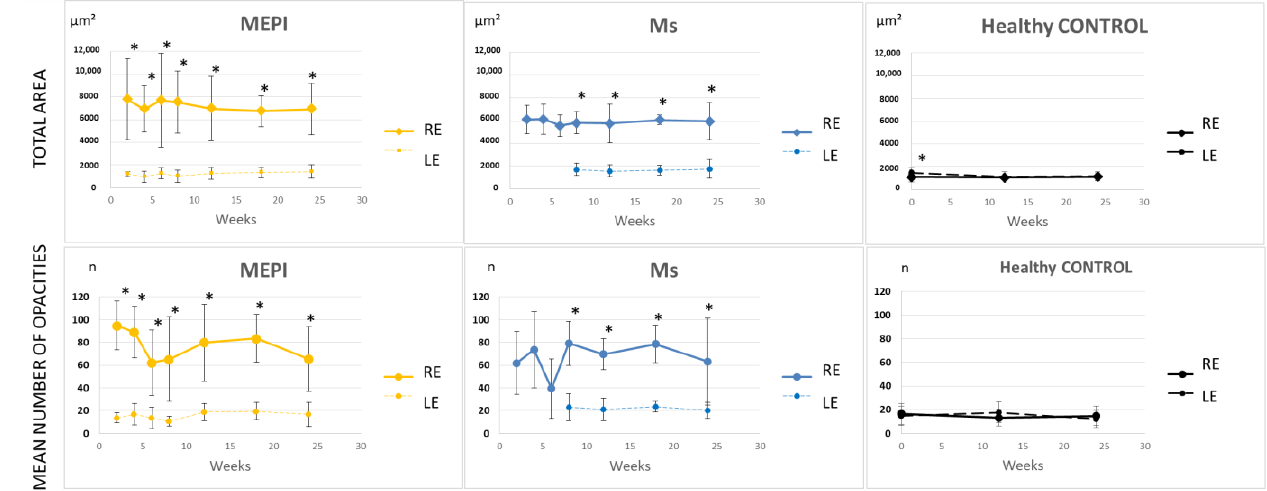
Figure 7. Changes in total immune response ( a ) and cellular quantification ( b ) in both glaucoma models and healthy controls. Abbreviations: RE: right eyes; LE: left eyes; MEPI: model induced by sclerosing the episcleral veins; Ms: model induced by injecting microspheres into the anterior chamber; n: number; *: statistical significance, p < 0.05, using ANOVA test.